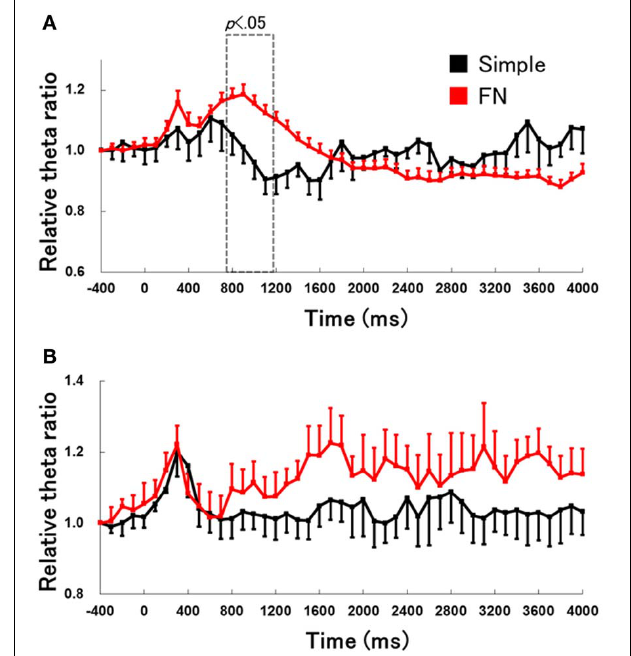
(A) and non-RFTs (B) of the early learning stage of the simple discrimination and FN tasks. The 0-ms period indicates the onset of stimulus presentation. The period was divided into 45 sub-periods of 100ms each. The mean hippocampal theta power from 500 to 400ms before the stimulus onset was counted as the − 400-ms period (no stimuli were present and no rats pressed the lever during this period), and the relative theta power calculated for each period was normalized to that of the − 400-ms period (relative theta power of each period = theta power of each period/theta power at the − 400-ms period). The hippocampal theta power increased in 800- to 1100-ms epochs during RFTs in the early learning stage of the FN task compared with in the early learning stage of the simple discrimination task (all p < 0 . 05 ). Error bars indicate